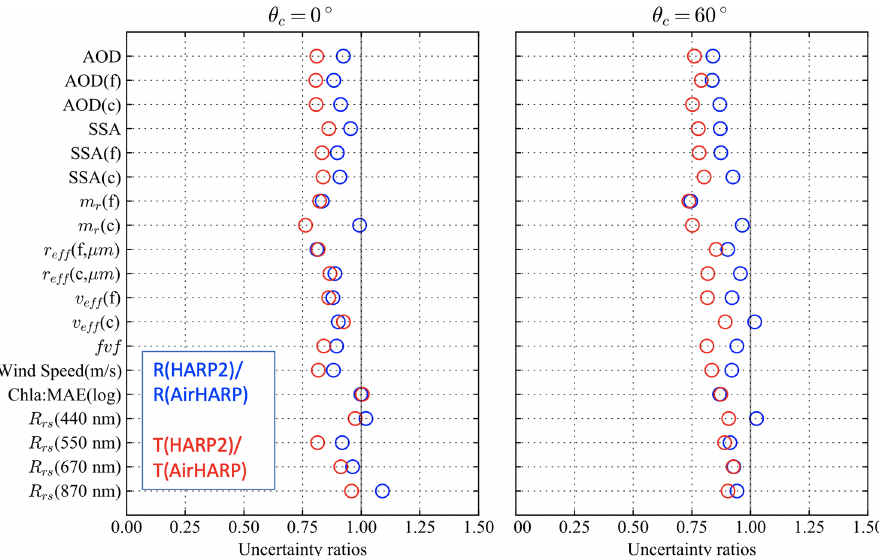
Figure 7. The ratio of the real ( R ) and theoretical ( T ) retrieval uncertainties between the AirHARP and HARP2 measurements for correlation angles equal to 0 and 60 ◦ . In the legend, R( HARP2 )/R( AirHARP ) denotes the ratio of real retrieval uncertainties between HARP2 and AirHARP, and T ( HARP2 )/T ( AirHARP ) denotes the ratio of theoretical